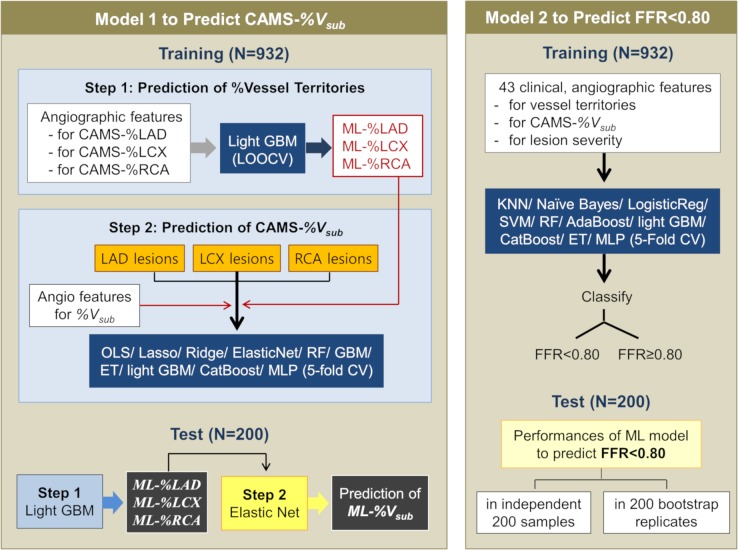
Workflow for the ML.CAMS-%RCA, CAMS-%LCX, and CAMS-%LAD are CCTA-measured percent ratios of the myocardial volumes supplied by the RCA, LCX, and LAD to the total left ventricular myocardial volume. ML-%RCA, ML-%LCX, and ML-%LAD are ML-predicted percent ratios of the myocardial volumes supplied by the RCA, LCX, and LAD to the total left ventricular myocardial volume. CAMS, CCTA-based myocardial segmentation; CAMS-%Vsub, CAMS-derived percent myocardial volume subtended to a stenotic segment; CCTA, coronary computer tomography angiography; CV, cross-validation; ET, extra tree; FFR, fractional flow reserve; GBM, gradient boosting machine; KNN, K-nearest neighbor; LAD, left anterior descending; LCX, left circumflex; LOOCV, leave-one-out cross-validation; ML, machine learning; ML-%Vsub, ML-predicted percent myocardial volume subtended to a stenotic segment; MLP, multilayer perceptron; OLS, ordinary least squares; RCA, right coronary artery; RF, random forest; SVM, support vector machine.